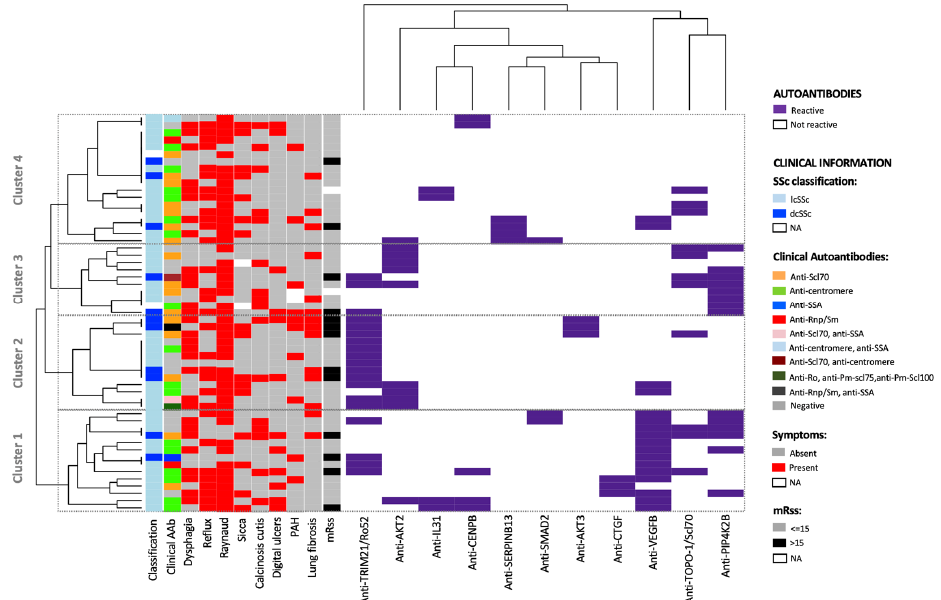
Figure 4. Heatmap and cluster analysis of the 11 selected autoantibodies in plasma of SSc patients. The cluster analysis revealed four main clusters corresponding to patient subgroups with different autoantibody signatures. Cluster 1 included most samples with anti-VEGFB antibodies, many of which have calcinosis and digital ulcers. Cluster 2 contained most samples with anti-TRIM21/Ro52, many of which have lung fibrosis and PAH. Cluster 3 included half of the SSc patients with anti- PIP4K2B, while cluster 4 had the lowest prevalence of autoantibodies among the identified clusters. Each row in the heatmap represents one SSc individual. Purple rectangles indicate the autoantibod- ies detected in each sample.